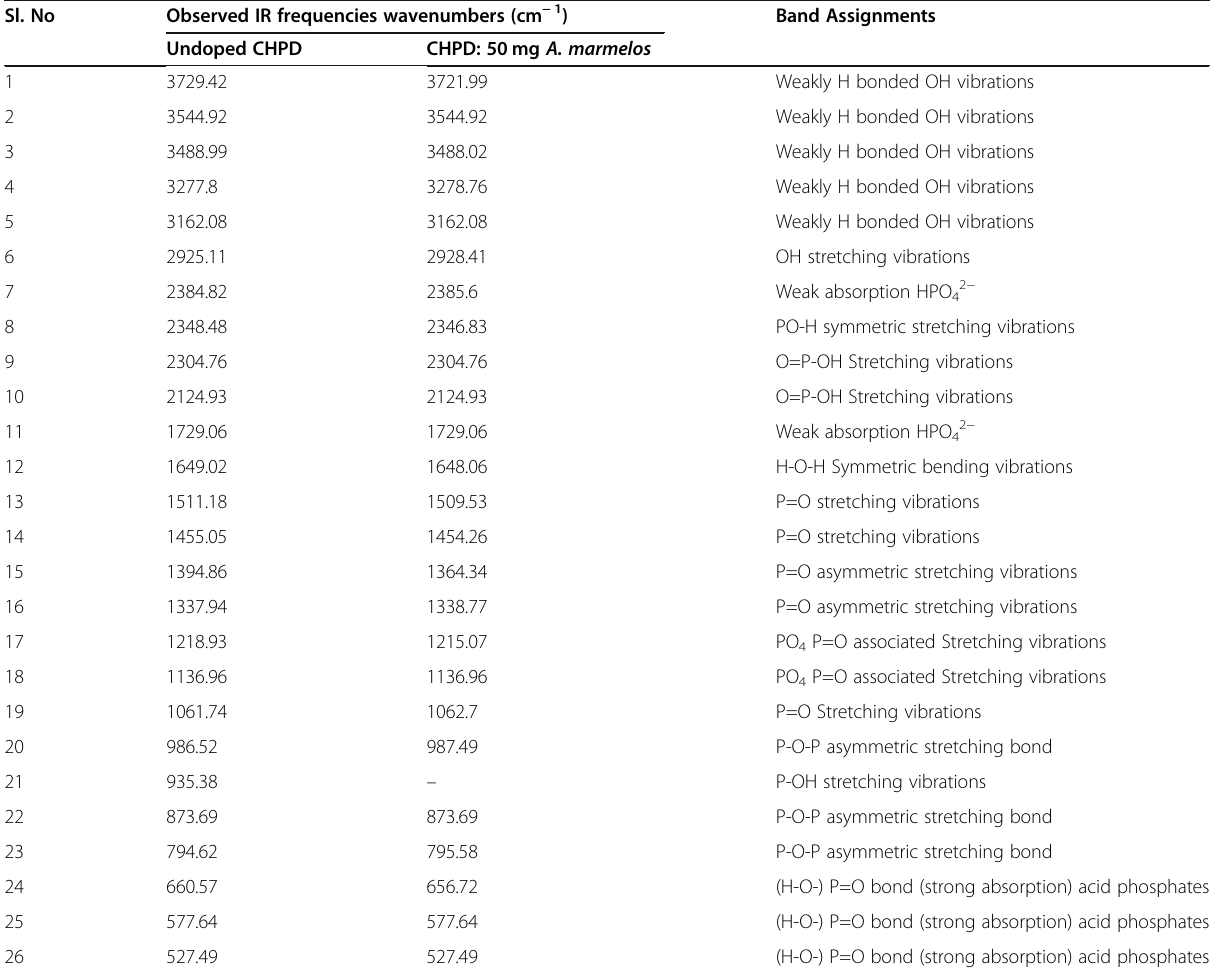
Table 4 Band Assignments and absorption bands of undoped and A. marmelos added CHPD crystals Sl.